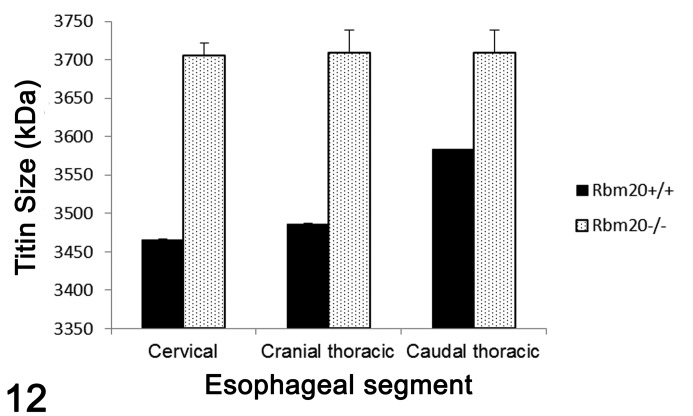
Larger TTN isoforms are seen in different portions of the esophagus in Rbm20–/– rats without megaesophagus. The average TTN
size in all parts of the esophagus of Rbm20–/–
rats was ∼3700 kDa, while the average TTN size in wild-type rats was approximately 200
kDa less and varied from ∼3460 kDa in the cervical portion to ∼3590 kDa in the caudal
thoracic portion. The data represent averages of multiple gels; standard deviations are
depicted. n = 4 for Rbm20+/+ cervical segments; n = 5
for Rbm20+/+ cranial and caudal thoracic
segments; n = 3 for Rbm20–/– cervical, cranial thoracic, and caudal thoracic
segments.